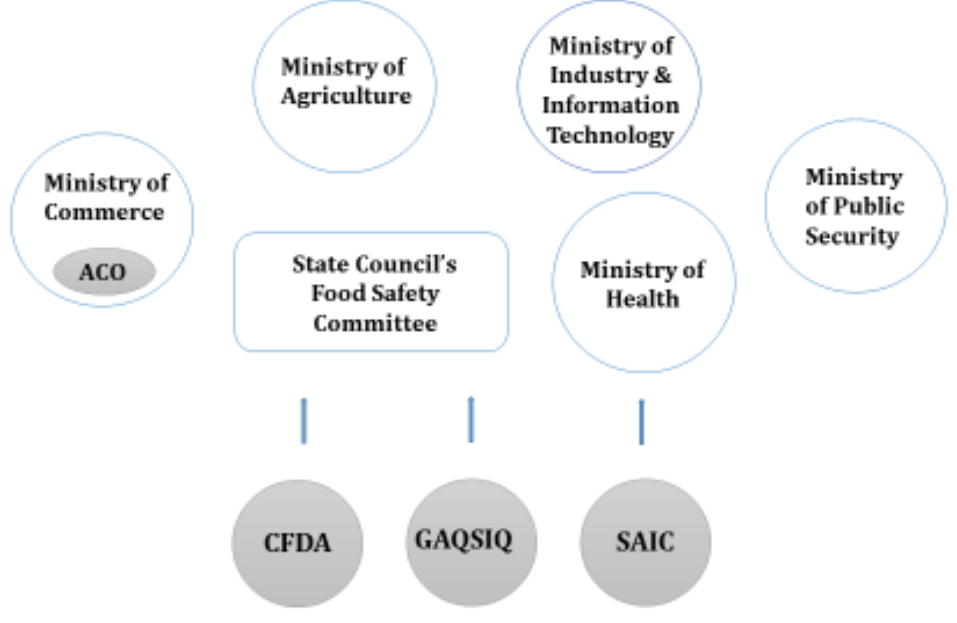
Figure 1: Structure of food safety administration in